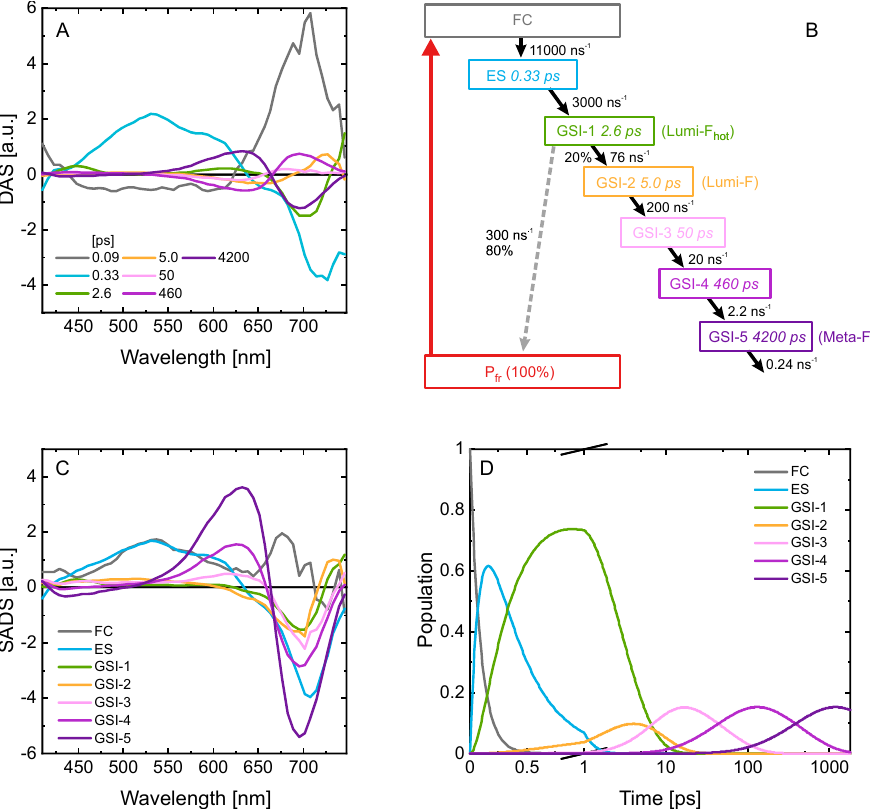
Figure 7. Decay-associated spectra (DAS) ( A ), species-associated difference spectra (SADS) ( C ) and populations ( D ) of individual states obtained from the GTA on the TA data of P fr *. The assignment to excited state or GS dynamics is based on the presence of ESA in the 410 to 600 nm range. ( B ) Schematic representation of the best kinetic model showing the rates (in ns − 1 ), the decay lifetimes (in ps), and the efficiencies of the corresponding reactions (in percent). Colors match the respective DAS, SADS and populations. The overall QY of the productive pathway was set to 0.2.